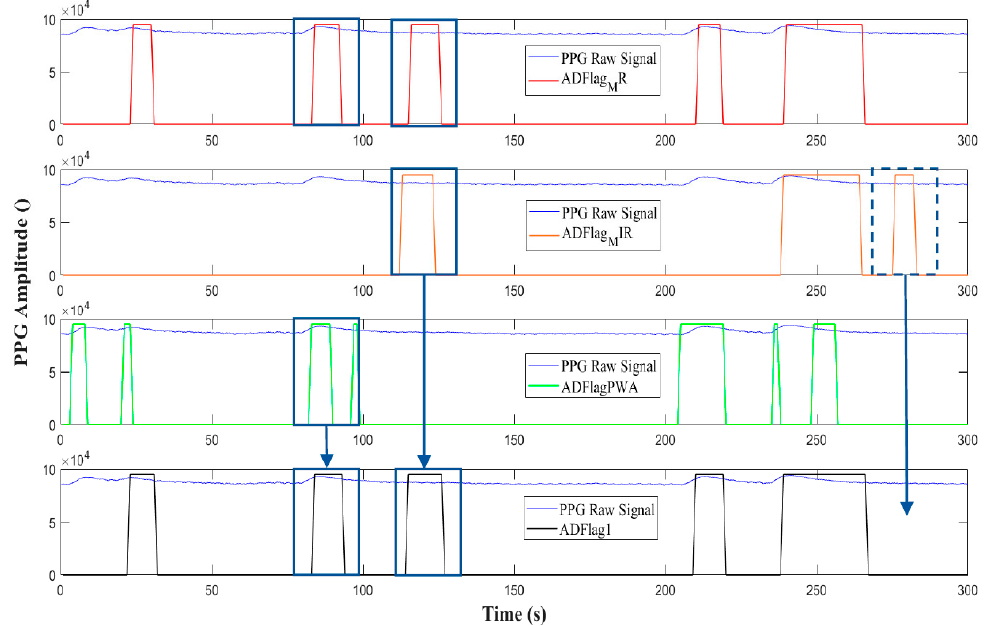
Figure 13. Operation of the apnea detection algorithm as an OR of two AND gates. Please note that in this case, the term “flag” represents a graphical representation of the apnea detection.